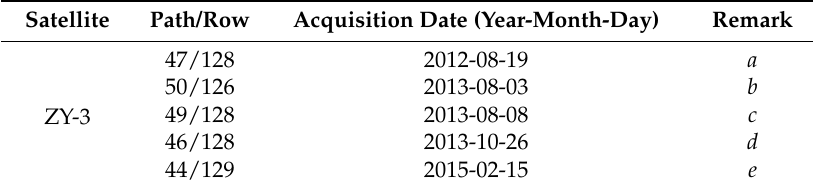
Table 2. List of remote sensing images for deriving glacier elevation changes in the Upper Reach of Shule River